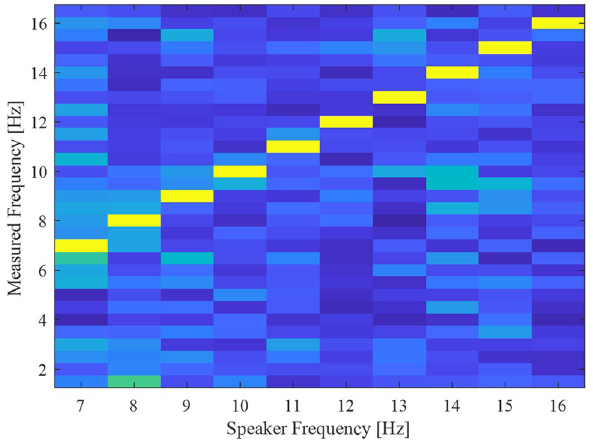
Figure 3. System calibration using a speaker. We used a speaker to create vibrations in a frequency range of 7–16 Hz and measured the spectrum with our system. The system detected the correct peak frequency with a 0.5 Hz